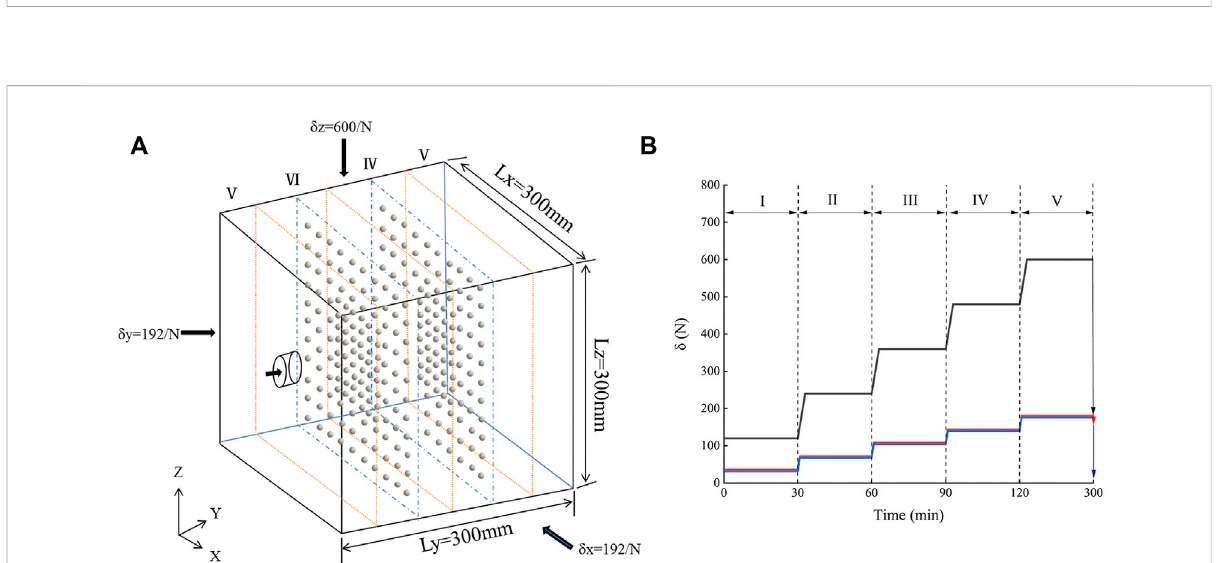
FIGURE 5 Isotropicstressappliedtocubespecimenduring fi veloadingstages: (A) Schematicdiagramofmodelexcavation, (B) Stressloadingtime-history